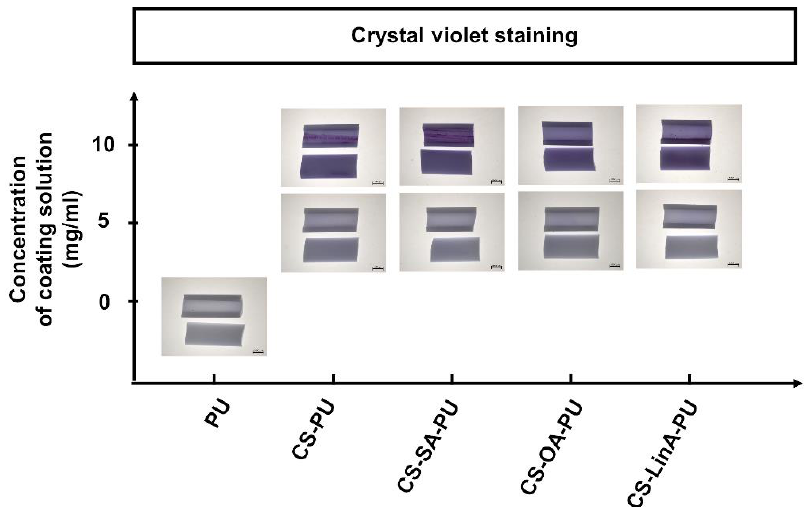
Figure 5. Optical microscopy photograph of untreated PU stent and the coated PU stents at two different concentrations (5 mg/mL and 10 mg/mL) of CS and CS-FA derivatives obtained from the crystal violet staining procedure. (CS-coated PU stent, CS-PU; CS-SA-coated-PU stent, CS-SA-PU; CS-OA-coated-PU stent, CS-OA-PU; CS-LinA-coated-PU stent, CS-LinA-PU).